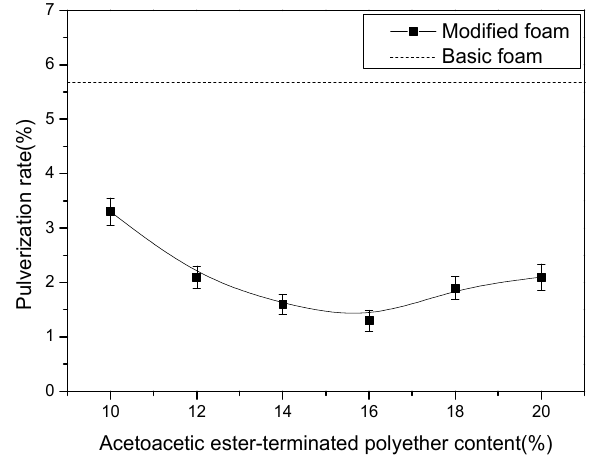
Figure 8. The effect of the acetoacetic ester-terminated polyether with different contents on the pulverization rate of the foam.